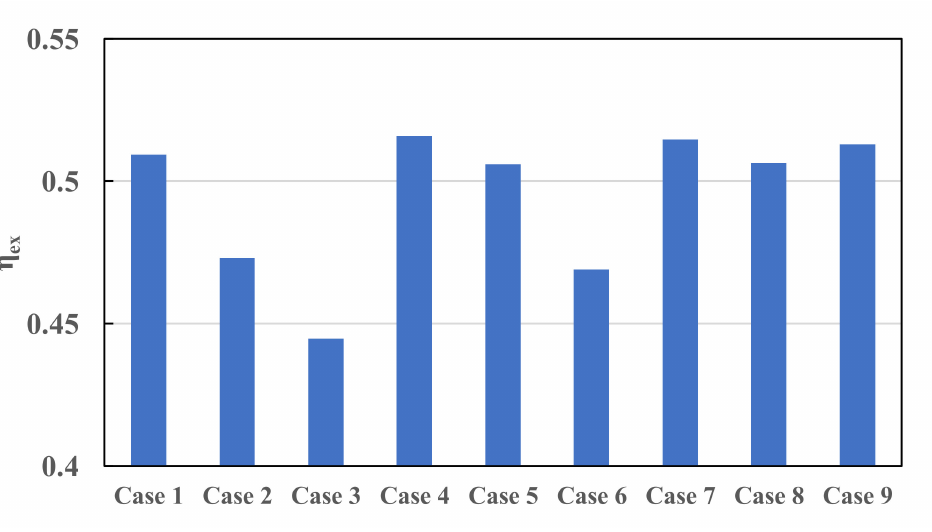
Figure 9. Exergy